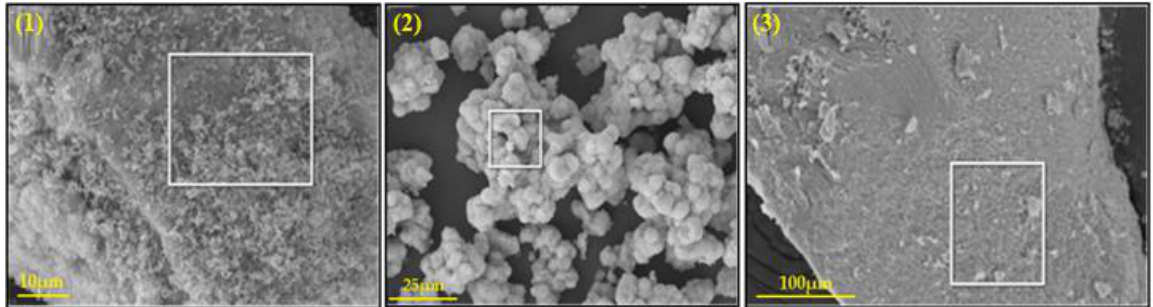
Figure 1. AFM images of catalyst - 1 ( 1 ), catalyst - 2 ( 2 ), and catalyst - 3 ( 3 ) at different magnifications.